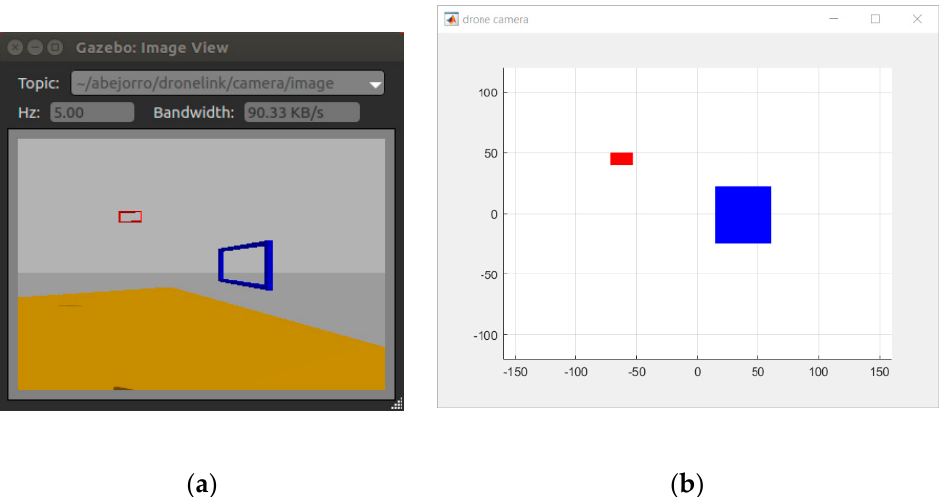
Figure 5. Example of video image processing: ( a ) original image captured by the drone camera; ( b ) rectangles delimiting the frames during the processing.